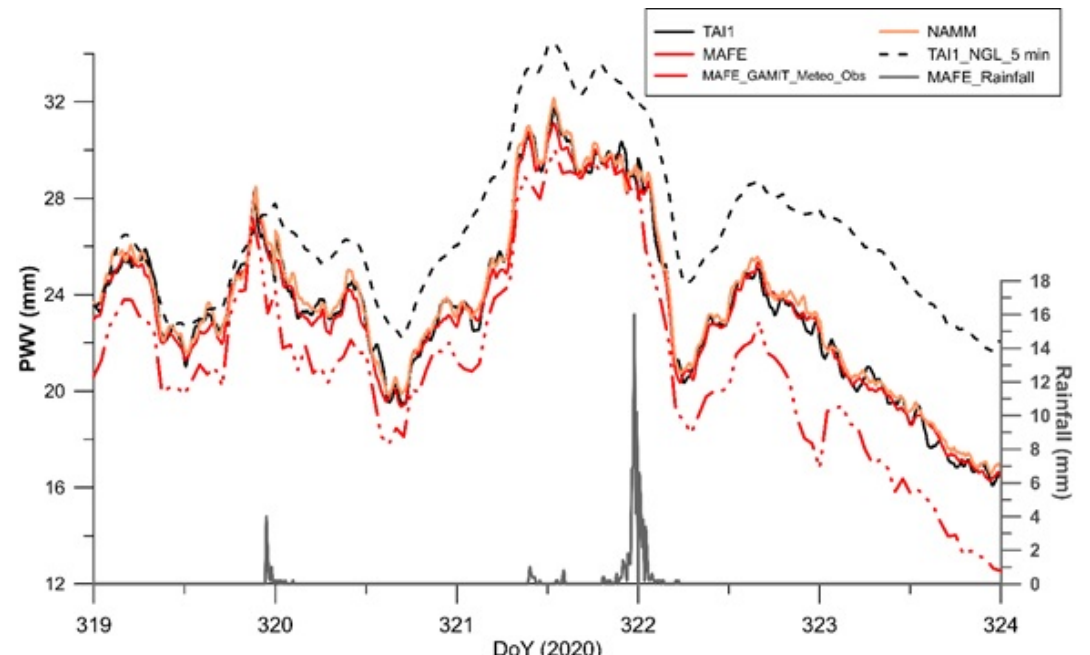
Figure 9. Thirty-second values of PWV, obtained with CSRS-PPP analysis, for a selection of stations of NeVoCGPS network close to MAFE, where weather observations are collected, and rainfall amounts (grey curve); NGL and Gamit solutions for TAI1 and MAFE stations, respectively, are also plotted as a reference.